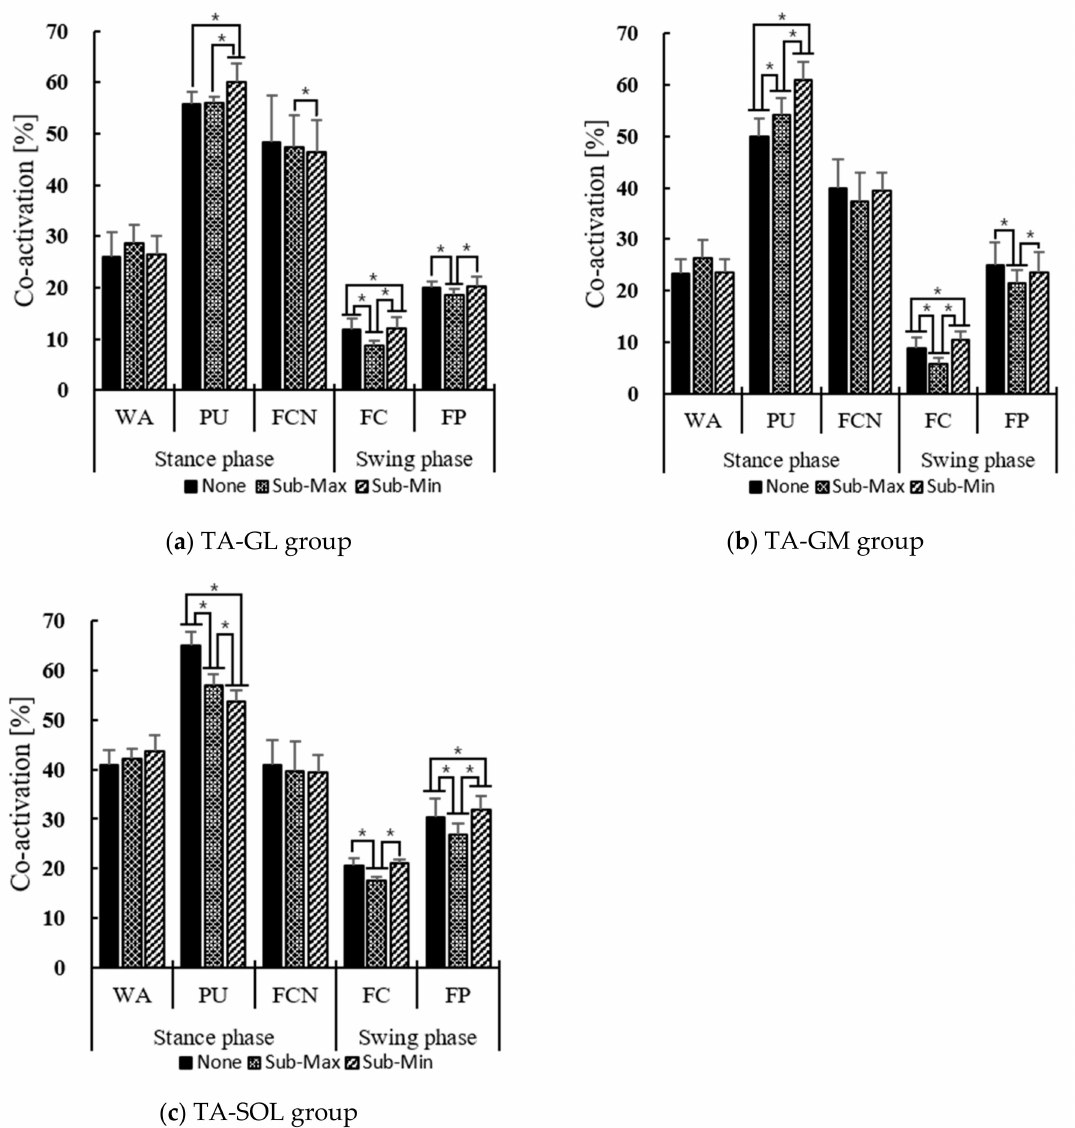
Figure 5. Mean value ( ± standard deviation) of co-activation of each gait phase according to the vibratory stimulation conditions at the sub-threshold intensity of each muscle group: ( a ) TA-GL group, ( b ) TA-GM group, ( c ) TA-SOL group, * indicates statistical significance through post-hoc tests between vibratory stimulus conditions ( p <